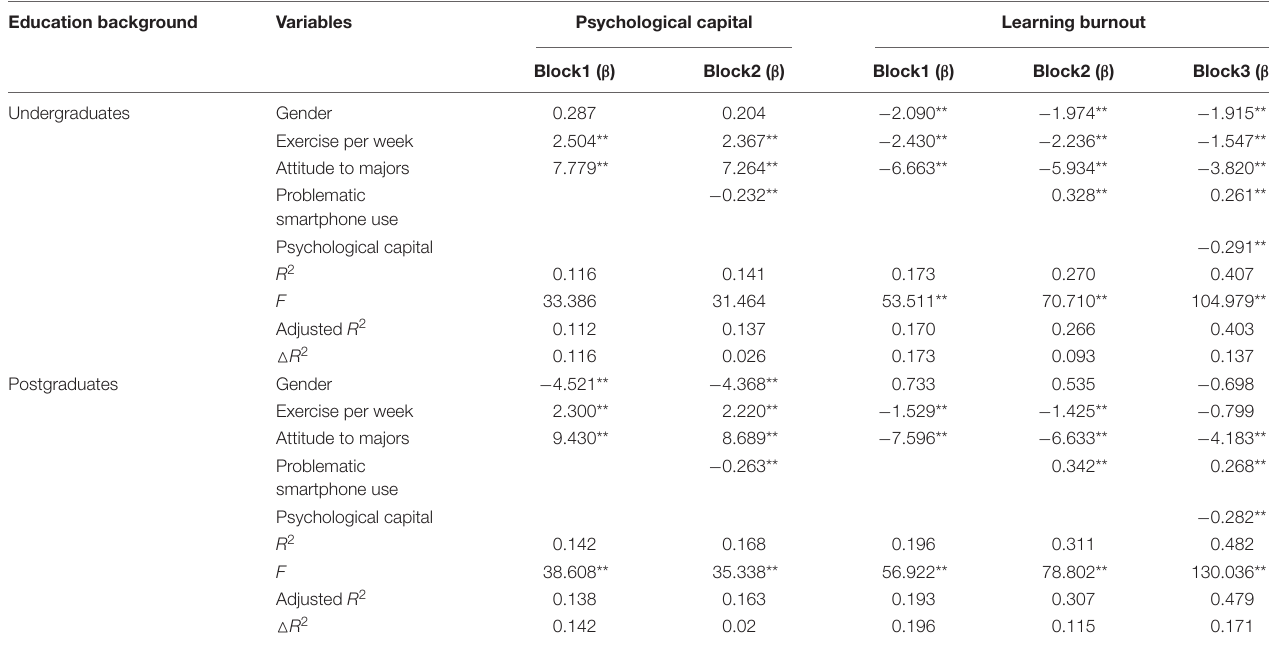
TABLE 3 | The effect of problematic smartphone use and psychological capital on learning